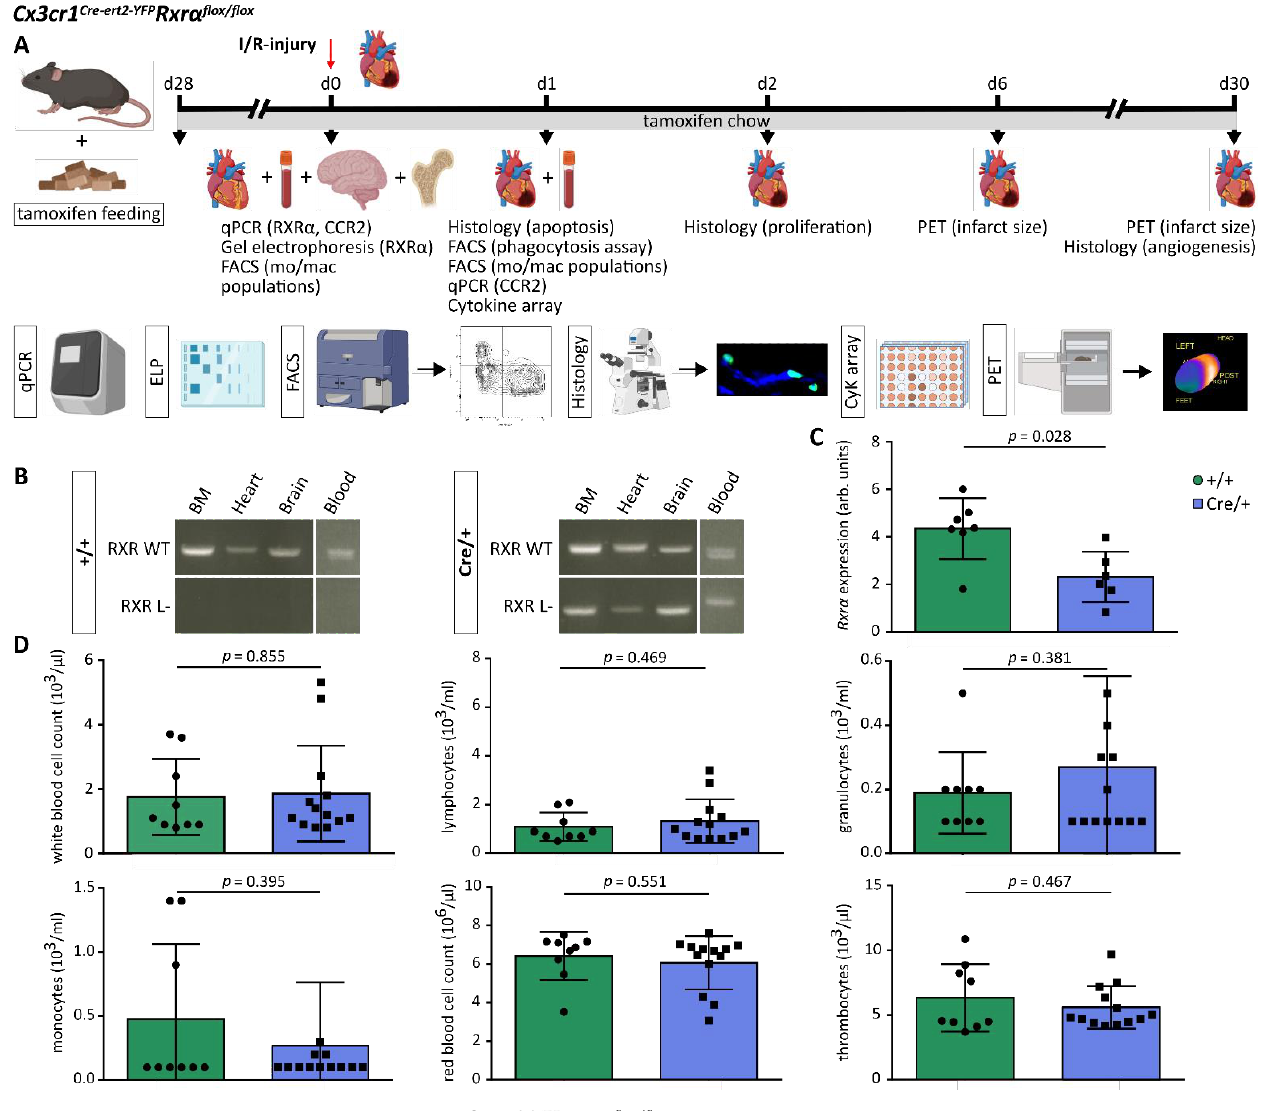
Figure 1. Cx3cr1 Cre-ert2-YFP Rxrα flox/flox mice show reduced expression of Rxrα in blood monocytes, which has no impact on PB parameters. ( A ) Study design (created with BioRender.com); ( B ) Rxrα wildtype allele and Rxrα L- allele expression in PB and different tissues of Cx3cr1ΔRxrα and control mice assessed by PCR and gel electrophoresis; ( C ) comparison of blood monocyte Rxrα expression between Cx3cr1ΔRxrα and control mice; ( D ) analysis of different blood parameters in Cx3cr1ΔRxrα and control mice. Arb: arbitrary; BM: bone marrow; CCR2: C-C chemokine receptor type 2; control (+/+): control mice [littermates with a floxed Rxrα allele but without Cre expression]; Cx3cr1ΔRxrα (Cre/+): mice with a floxed Rxrα allele and Cre expression; CyK: cytokine; ELP: electrophoresis; FACS: Fluorescence activated cell sorting; I/R injury: Ischemia/Reperfusion injury; mac: macrophage; mo: monocyte; PB: peripheral blood; PET: positron emission tomography; Rxr: Retinoid X receptor; qPCR: real-time polymerase chain reaction.